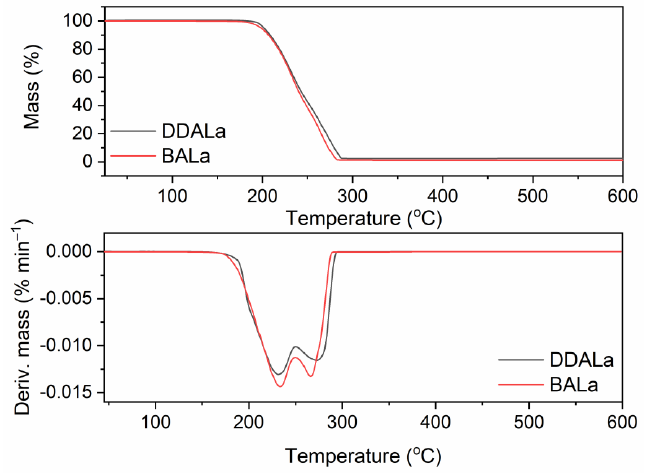
Figure 1. Thermogravimetric (TG) and Differential Thermogravimetric (DTG) curves for pure TSILs. T 5% was determined as the onset temperature of the thermal decomposition of TSILs.